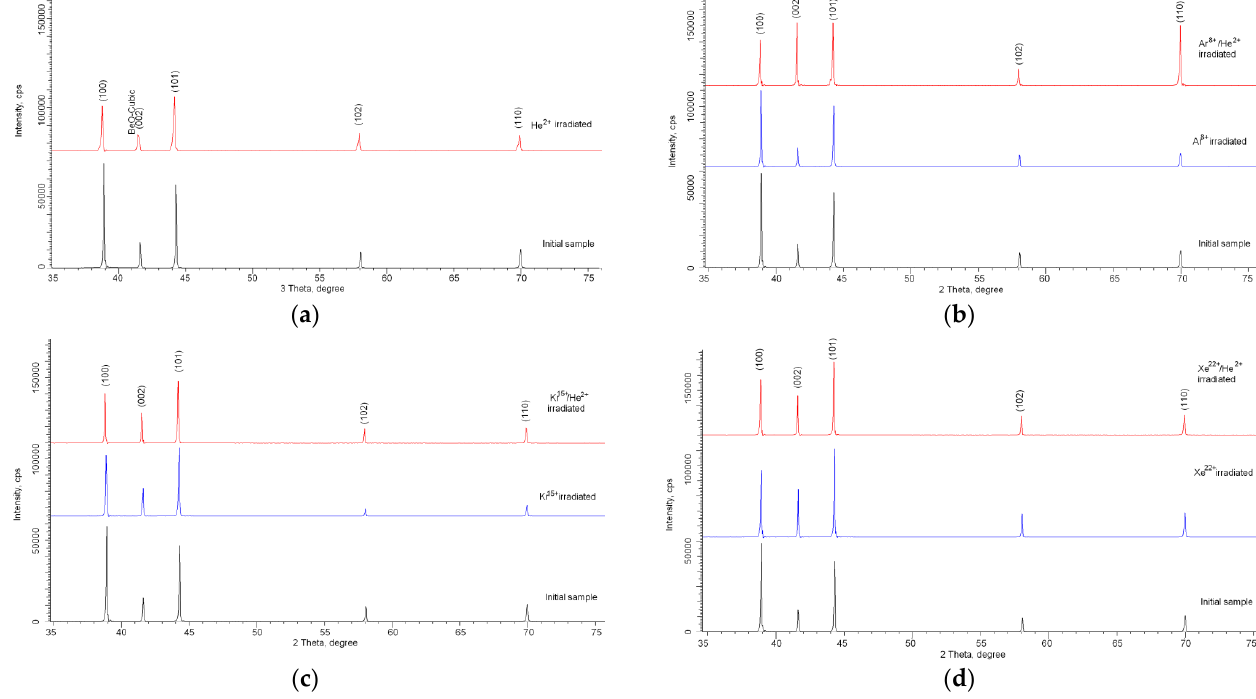
Figure 2. Results of X-ray diffraction analysis of the samples under study, depending on different irradiation types: ( a ) X-ray diffraction patterns of initial samples before and after irradiation with He 2+ ions, ( b ) X-ray diffraction patterns of samples modified with heavy Ar 8+ ions before and after irradiation with He 2+ ions, ( c ) X-ray diffraction patterns of samples modified with heavy Kr 15+ ions before and after irradiation with He 2+ ions, and ( d ) X-ray diffraction patterns of samples modified with heavy Xe 22+ ions before and after irradiation with He 2+ ions.